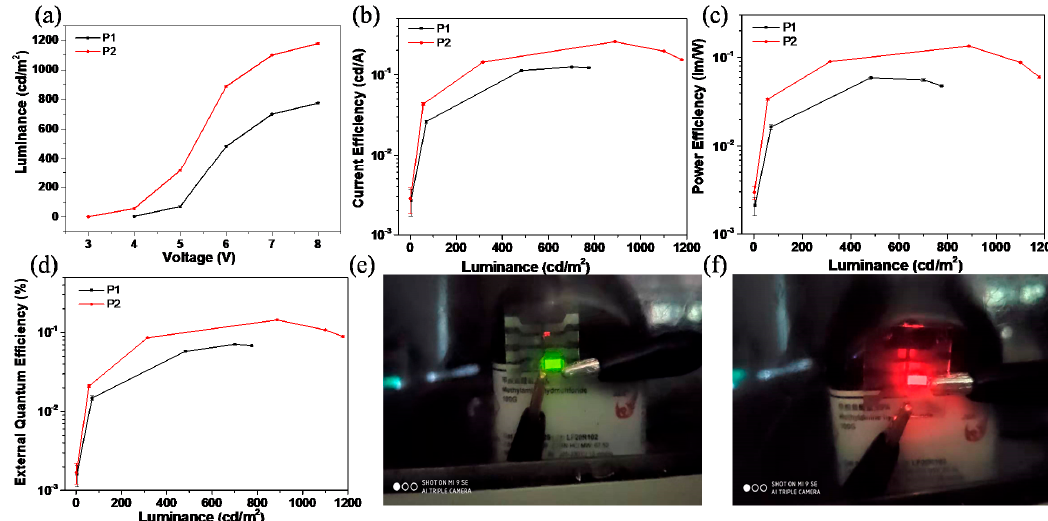
Figure 6. ( a ) The luminance–voltage ( L – V ) characteristics; ( b ) Current efficiency–luminance ( J – L ) curves; ( c ) Power efficiency versus luminance plots; ( d ) External quantum efficiency–luminance characteristics of P1 and P2 . ( e ) The photograph of P1- based device with green emission at 8 V; ( f ) The photograph of P2 -based device with red emission at 8 V. Table 3. Luminescence characteristics of P1 and P2 -based OLED devices.